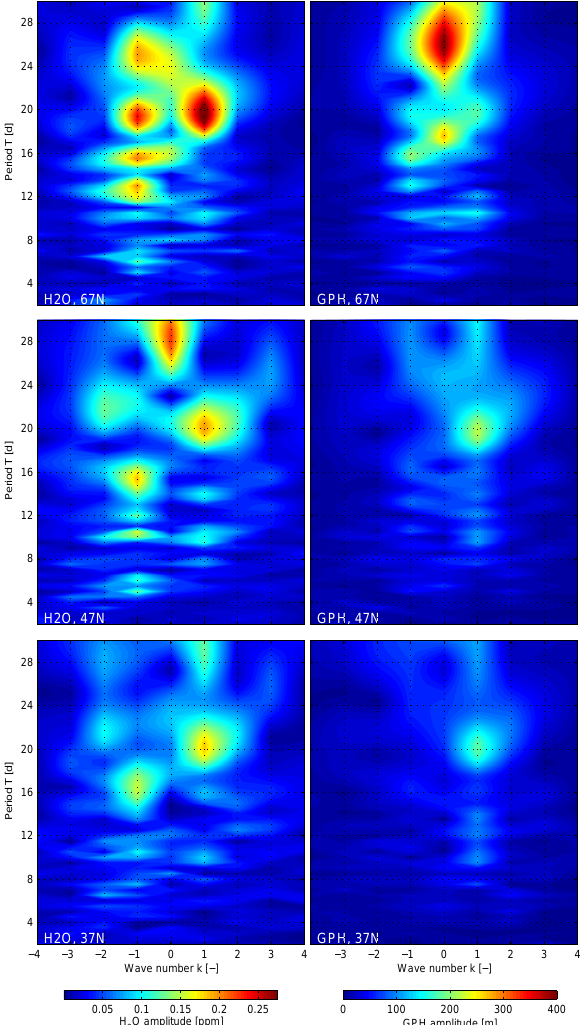
Figure 5. Periodogram for traveling and stationary planetary waves in water vapor (left panels) and geopotential height (right panels) on 0.05hPa (approximately 70km) as observed by Aura MLS at the latitudes of the ground-based microwave radiometers (67, 47 and 37 ◦ N, from top to bottom) during boreal winter 2011/2012.